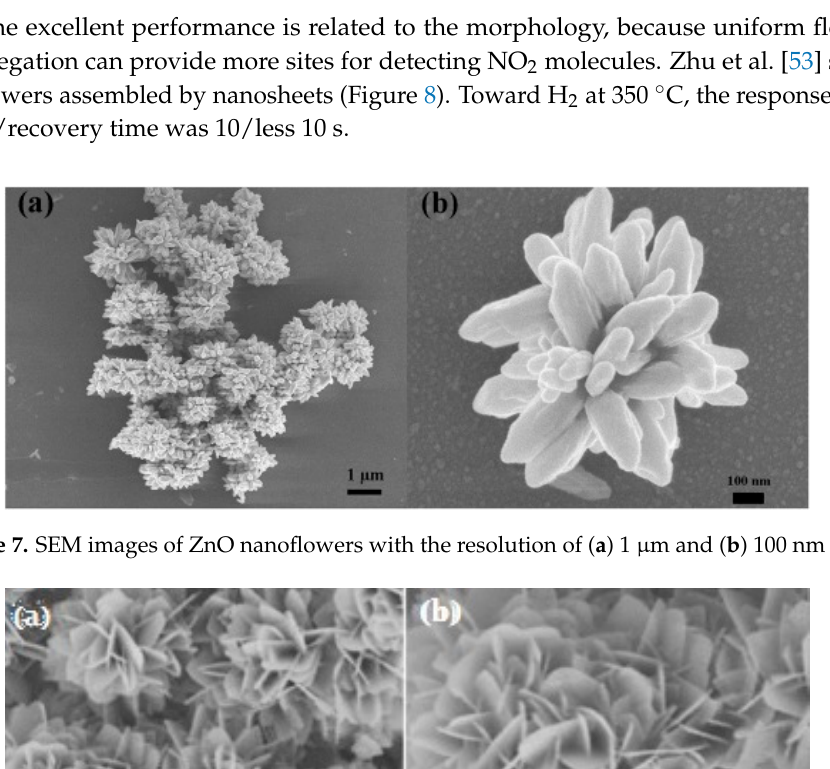
8 of 25 Figure 6. FESEM images of SnO (cid:2879) to Sn (cid:2870)(cid:2878) was ( a ) 4/1, ( b )